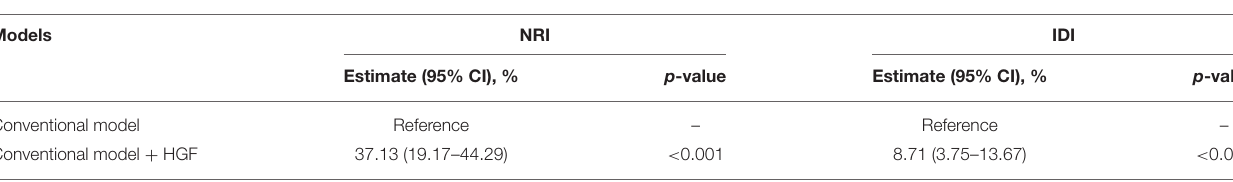
TABLE 3 | Reclassification of the primary outcome by plasma HGF in AIS patients. Models NRI